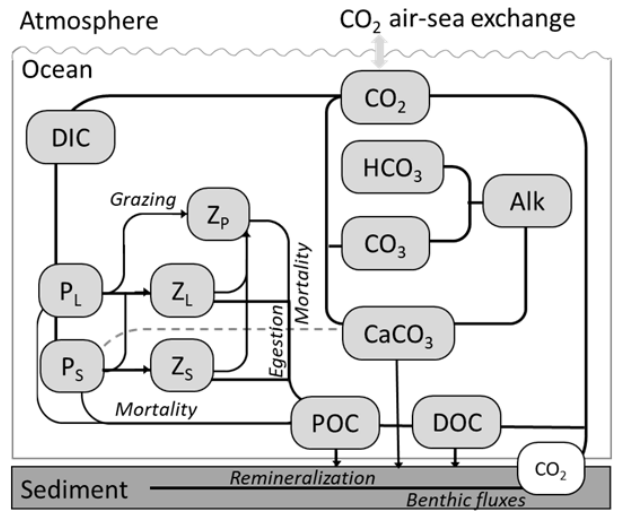
Figure 2. Schematic plot showing major processes incorporated in the carbon